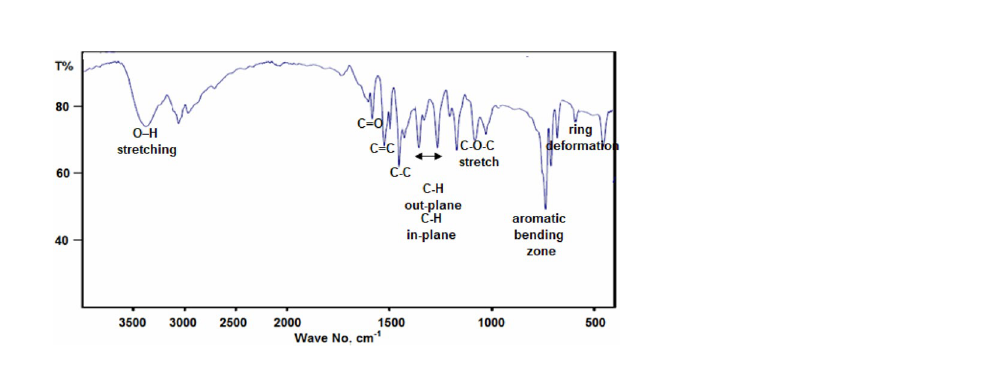
Figure 2. Chemical structures of the key components of BLE extract.